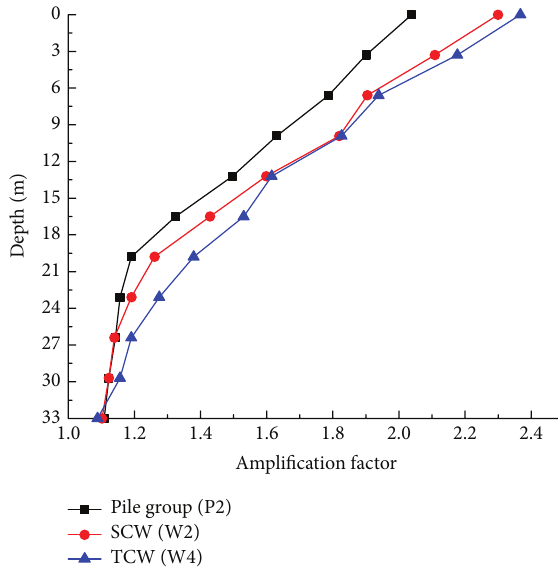
Figure 16: Amplification factor of structural peak acceleration.